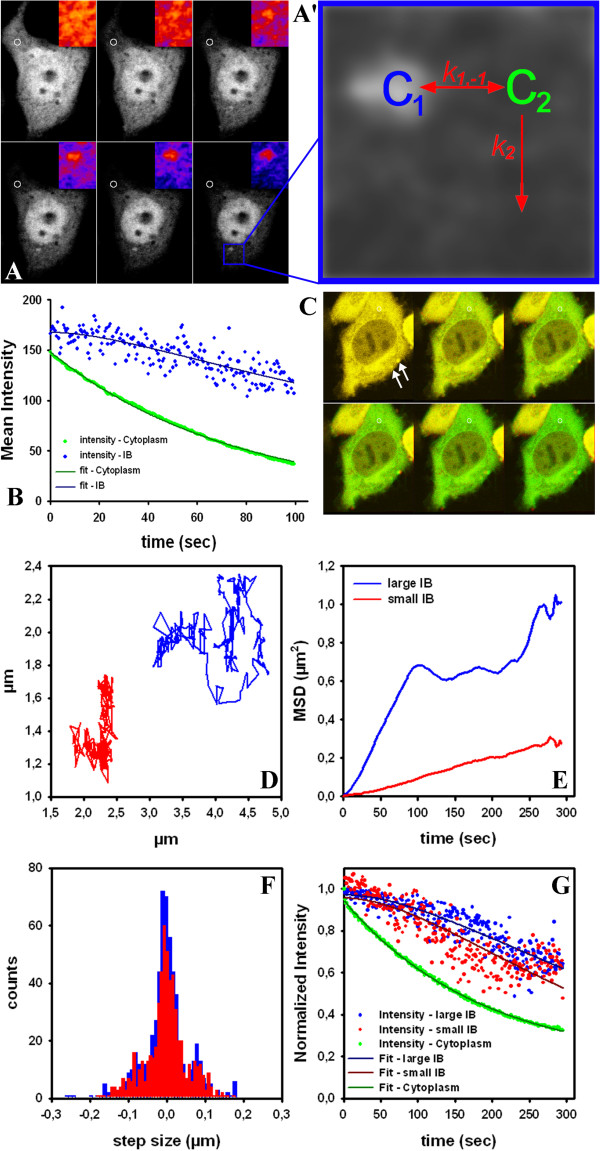
Multi-compartment modeling of FLIP data reveals dynamics of eGFP-Q73 in inclusion bodies. A FLIP experiment was performed in CHO cells expressing eGFP-Q73 as described in legend to Figure 6. A, montage of every 20th frame of the data. Inset is a zoom of the small box pointing to an IB; a FIRE LUT is used for visualization purposes. A’, sketch of the multi-compartment (MC) model used for determining binding/dissociation parameters. B, FL kinetics for the IB (blue dots) and for a region in the cytoplasm (green dots) with overlayed fit to the MC model for the IB (compartment 1; dark blue line) and for the cytoplasm (compartment 2; dark green line). C, another FLIP sequence imaged with a total frame rate of 2.4 sec. First frame of the time series is shown in green, while selected subsequent frames are overlayed in red. This color coding visualizes movement of two IB’s at the cell edge (large one up and small one below; arrows). Tracking of the mobile IB’s and measurement of their intensity was performed using the SpotTracker plugin for ImageJ [47]. D, x,y-plot of the trajectories of the IB’s; E, mean square displacement (MSD) calculated from the trajectories; F, step length distribution between subsequent steps; G, fluorescence intensity of eGFP-Q73 in the IB’s (blue dots = large IB; red dots = small IB) and in the cytoplasm (green dots) and fit with the MC model for the IB’s (compartments 1, dark blue and red line, respectively) as well as for the cytoplasm (compartment 2, dark green line).